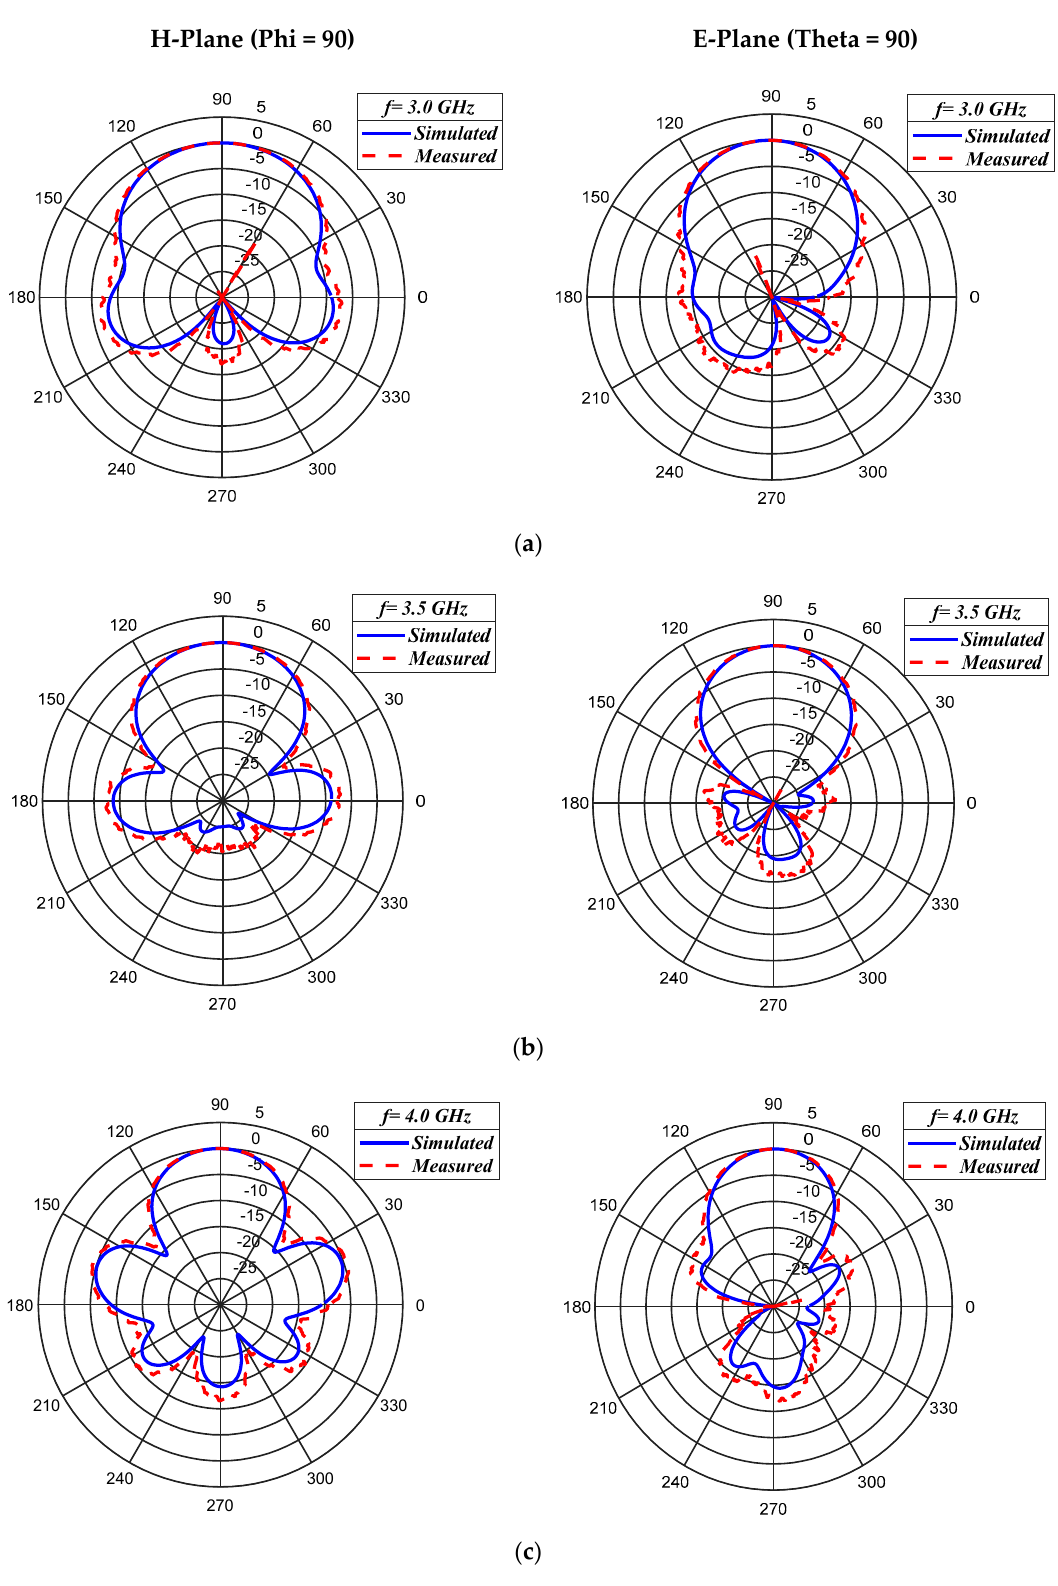
Figure 8. Simulated and measured normalized radiation patterns in E-Plane and H-plane of the proposed antenna, ( a ) f = 3 GHz, ( b ) f = 3.5 GHz and ( c ) f = 4.0 GHz.